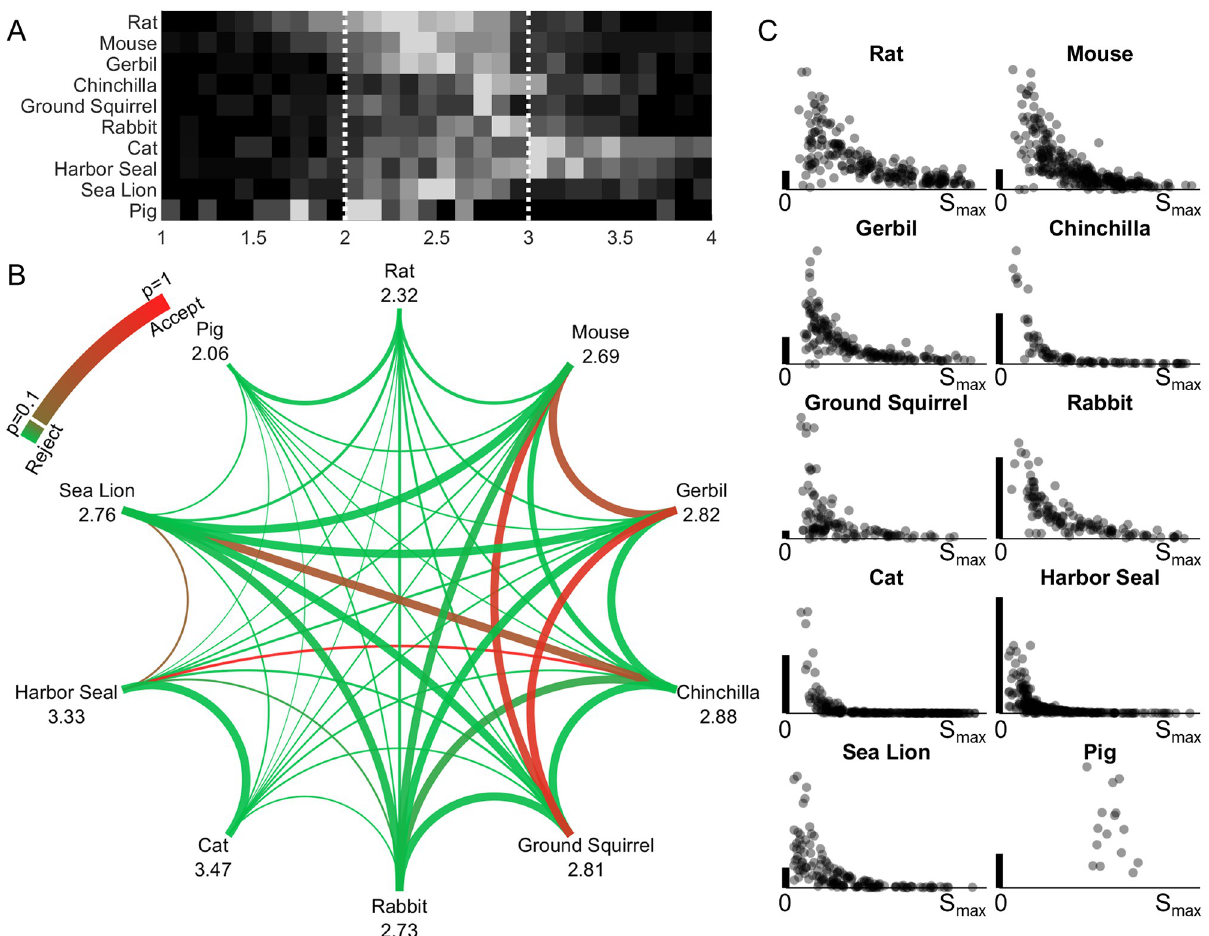
Fig 4. A fractional exponent model can be used to quantify whisker curvature. (A) A heatmap of exponent ( β ) values for whiskers of all species is shown. (B) This graph shows results of a cross-species comparison generated from the unpaired t-tests in step 2. The number under each species name is the generalized fractional exponent β value determined in step 3 (optimized across all whiskers for that species), and the thickness of each line connecting two species represents the difference in magnitude of the two β values, with thicker lines indicating more similar values. The color of the curve indicates the p-value of the student’s unpaired t-test. The green color rejects the null hypothesis, indicating that whiskers can be distinguished, while the red color accepts the null hypothesis, indicating that whiskers cannot be distinguished. (C) For each species, the coefficients a β are plotted as a function of whisker arc length (S max ). The values of a β are highly variable for short whiskers compared to long whiskers. In all plots the vertical scale bar (heavy black vertical line) represents 0.005mm 1- β Each point is transparent gray so darker colors indicate a greater density of points.